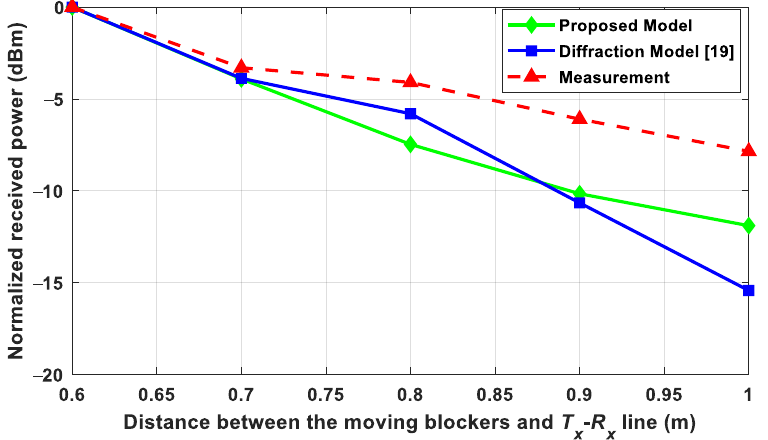
Figure 8. Comparison of the normalized received powers from the measurements and the